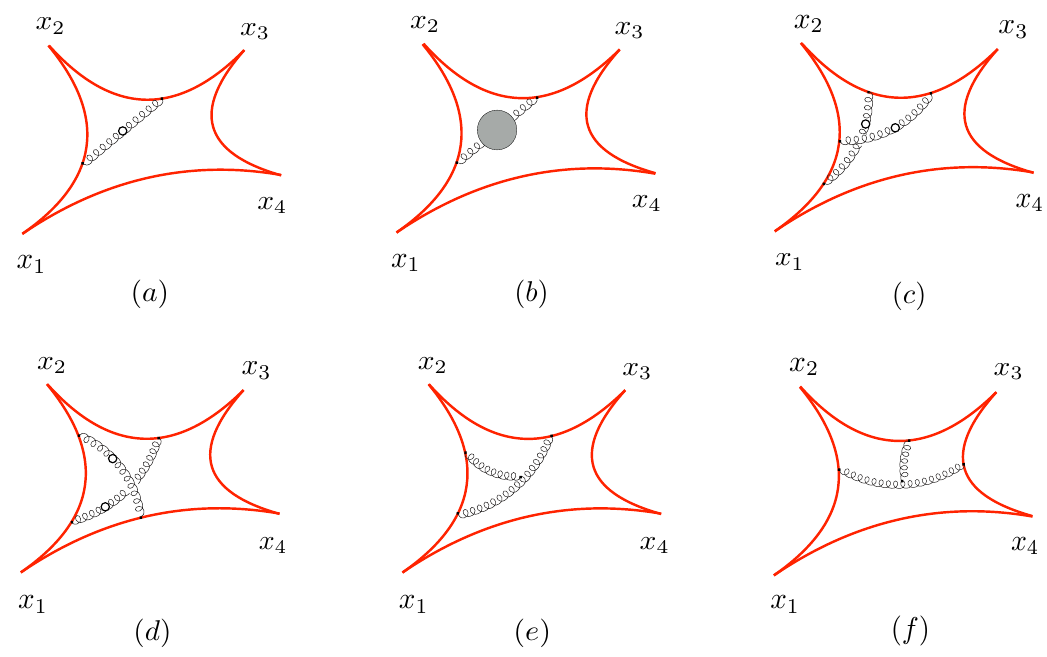
Figure 3 . One- and two-loop Feynman graphs possessing at least double logarithmic dependence on the off-shellness. The large grey blob stands for the virtual loops of gluons, ghosts, fermions and scalars, while the small empty one is the insertion of the Feynman gauge YM action (5.1). The multiplicity factors of the displayed graphs are (from left top to right bottom) m α = { 4 , 4 , 4 , 4 , 8 , 4 } . Notice that the Lagrangian insertions in the last two graphs were integrated out by means of fields’ equations of motion as explained in section